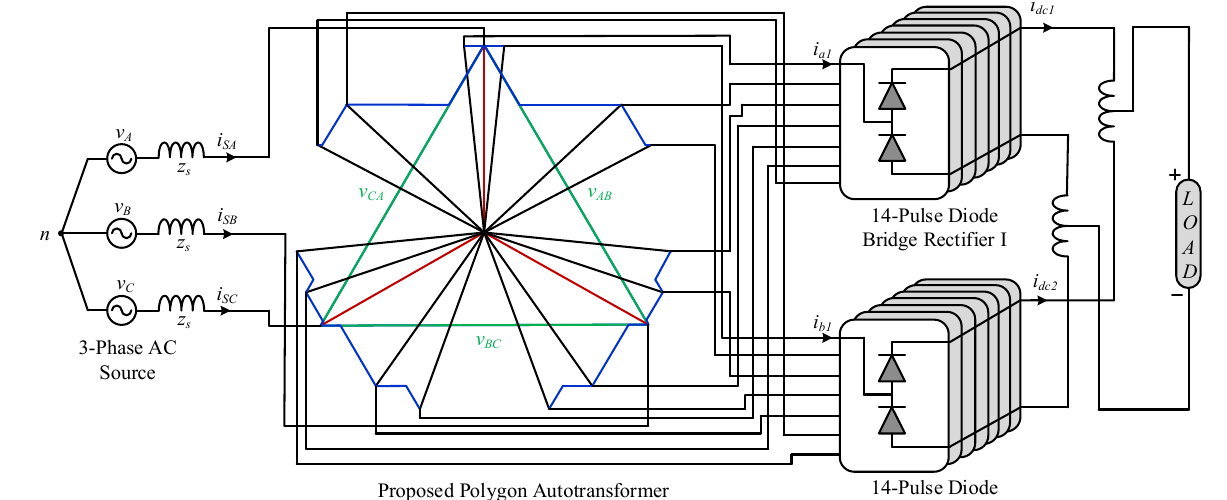
Figure 2. The PCA configuration of the 28-PR.